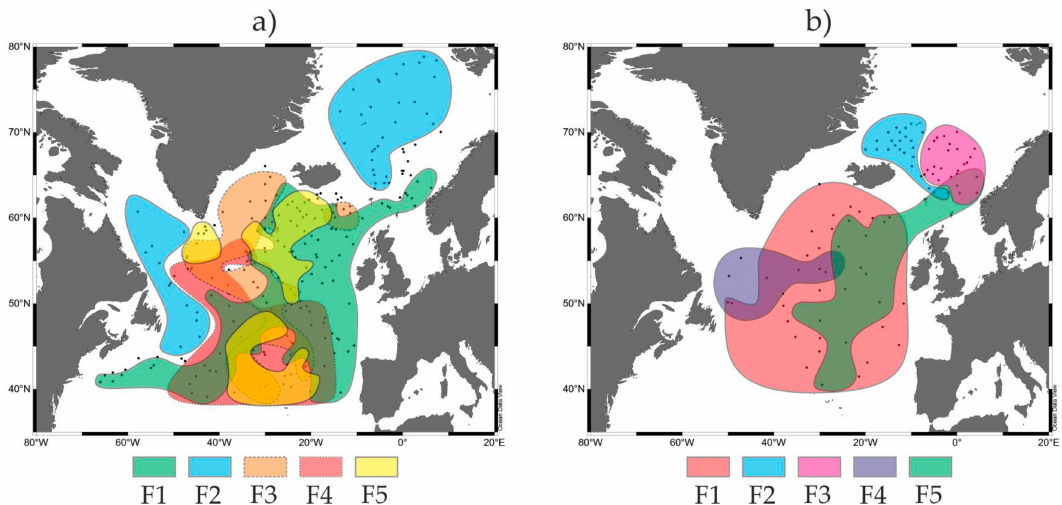
Figure 3. Generalized areas of 5 main Factors F1–F5 in the surface sediments of the North Atlantic with for each the loading for planktic foraminiferas (PF) and radiolarians (R), respectively: ( a ) PF (this study), ( b ) R (modified from [21] with simplification). F1 loadings >0.6 and >0.8, F2 loadings < − 0.9 and >0.9, F3 loadings >0.5, F4 loadings >0.4, F5 loadings